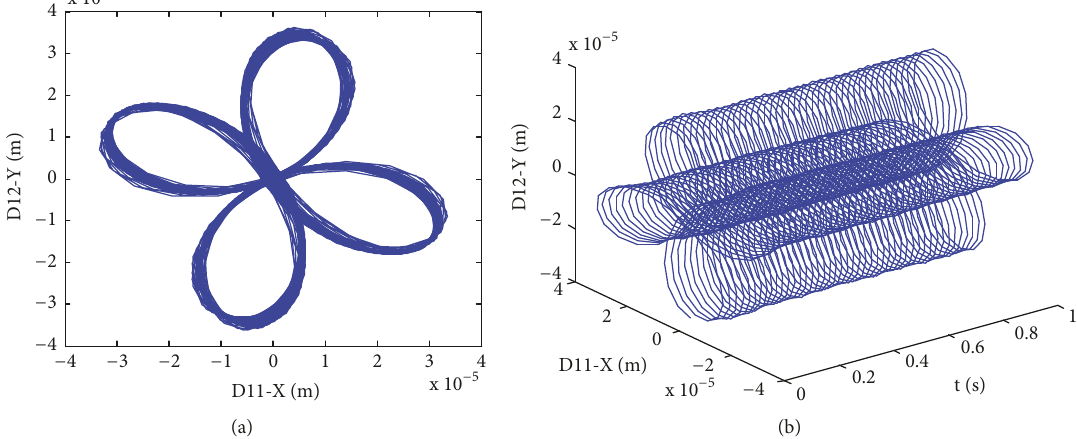
Figure 17: The synthesis of axis orbit is to extract the first two times fundamental frequencies of the D11 and D12 signals by the CFSM-PCA. (a) The axis orbit. (b) Relationship between axis orbit and